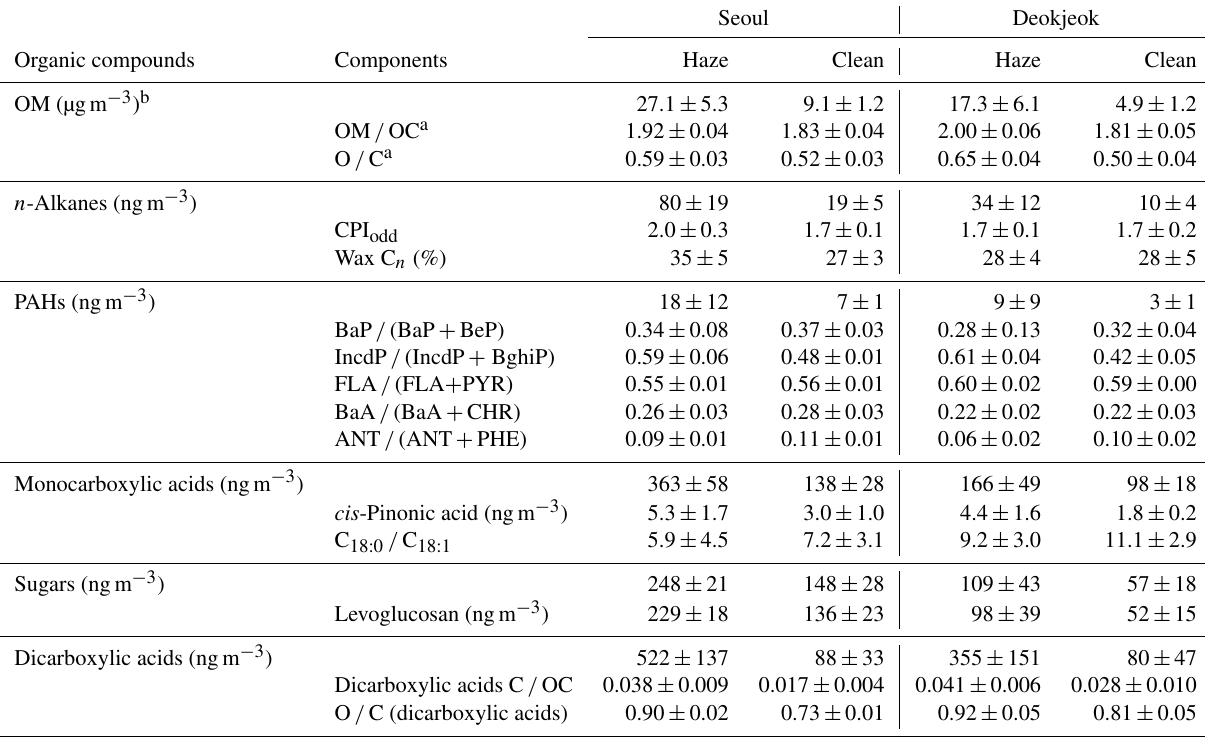
Table 2. The average and standard deviation of analyzed organic compound concentrations and diagnostic ratios in Seoul and Deokjeok for the haze (23–28 February 2014) and clean (5–9 March 2014)